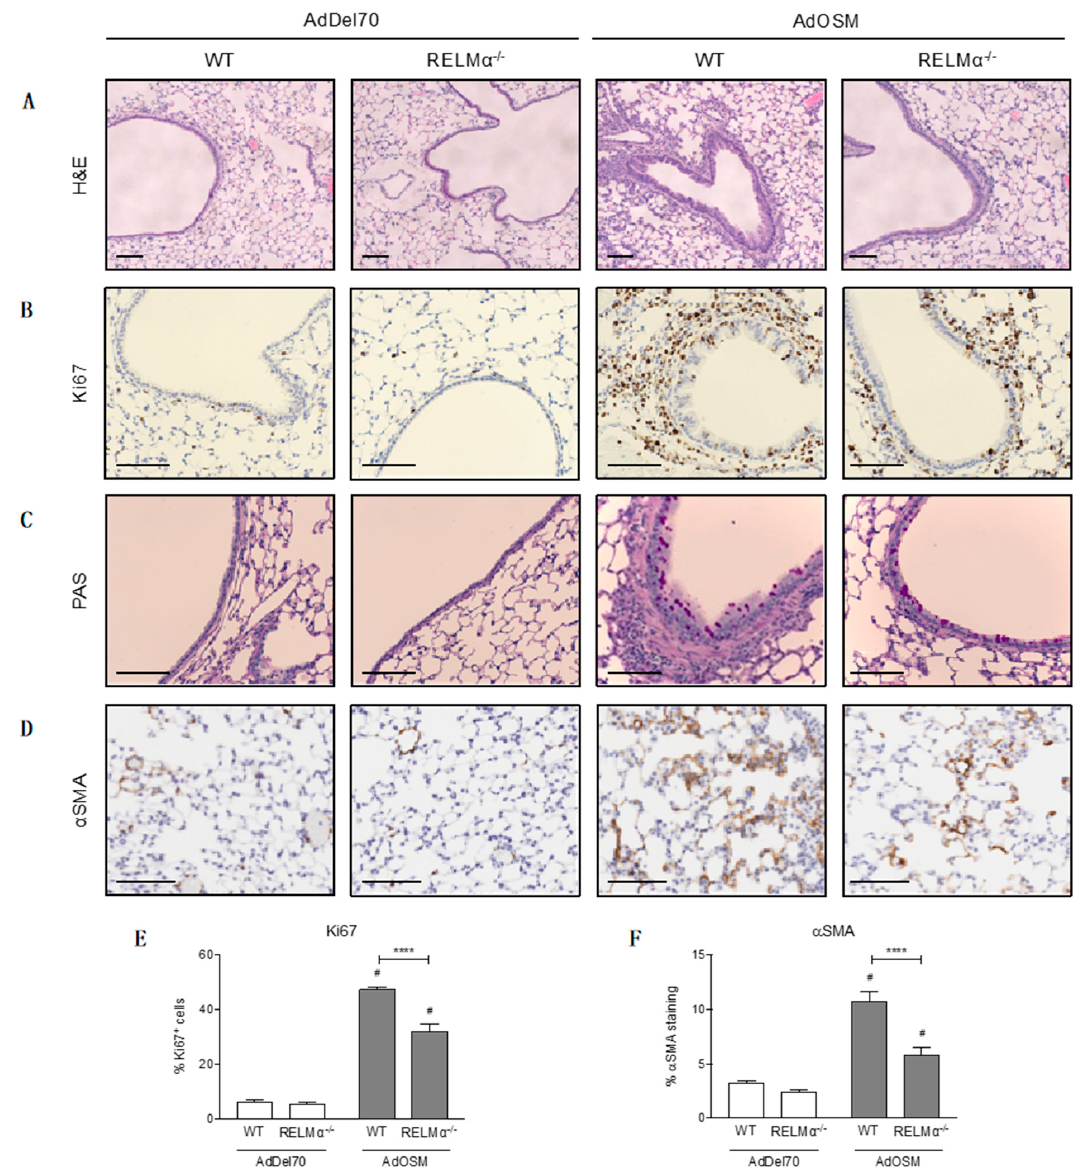
Figure 9. Histological analyses of formalin-fixed, paraffin-embedded lung tissue. Lung sections